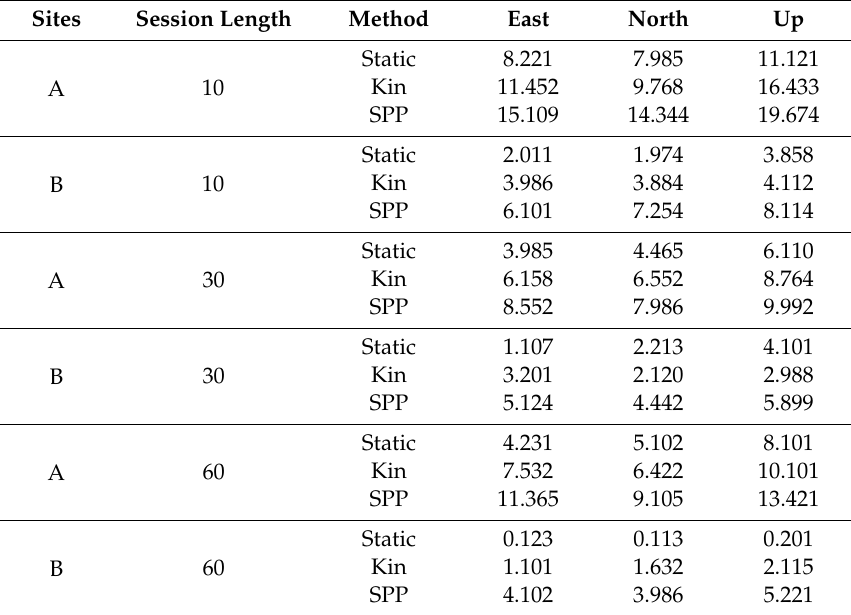
Table 3. Precision of the positioning results using Samsung Galaxy S8 + in meters.